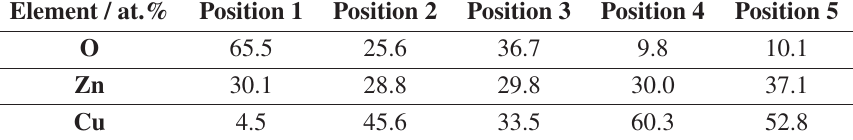
Table 2. Micro-compositions on the positions marked on Figure 3(b). by equations (5) and (6)